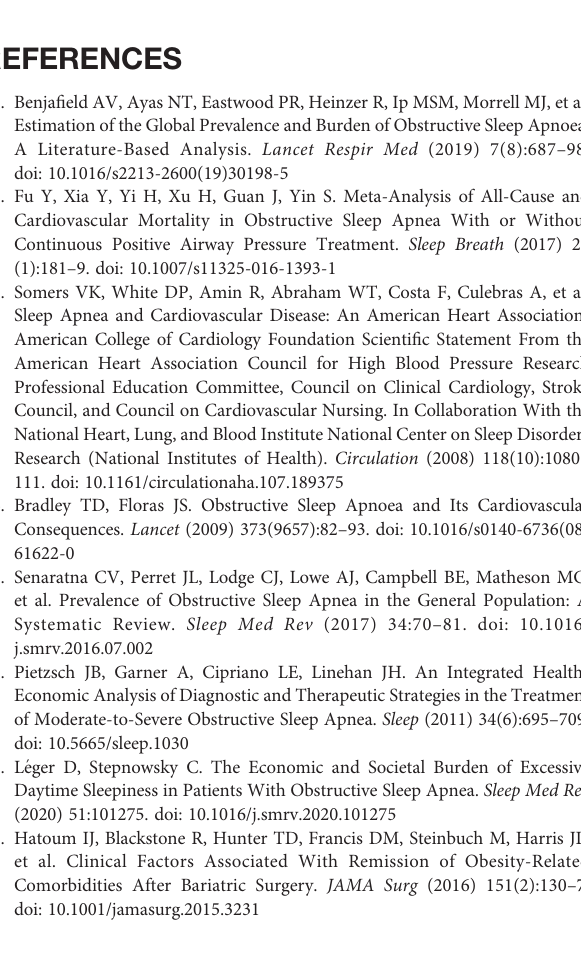
density lipoprotein cholesterol; ApoA-I, apolipoprotein A-I; ApoB, apolipoprotein B; ApoE, apolipoprotein E; Lp(a), lipoprotein (a). Supplementary Figure 2 | Heatmap based on the Spearman correlation matrix demonstrated clear correlations between the clinical indicators and metabolomic pro fi les of OSA patients before and after RYGB. OSA, obstructive sleep apnea; RYGB, Roux-en-Y gastric bypass surgery; SaO2, pulse oxygen saturation; BMI, body mass index; AHI, apnea – hypopnea index; ESS, Epworth sleepiness score; ODI, oxygen desaturation index; MAI, micro-arousal index; SBP, systolic blood pressure; DBP, diastolic blood pressure; FBG, fasting blood glucose; GHb, glycated hemoglobin; GA, glycated albumin; HOMA-IR, homeostasis model